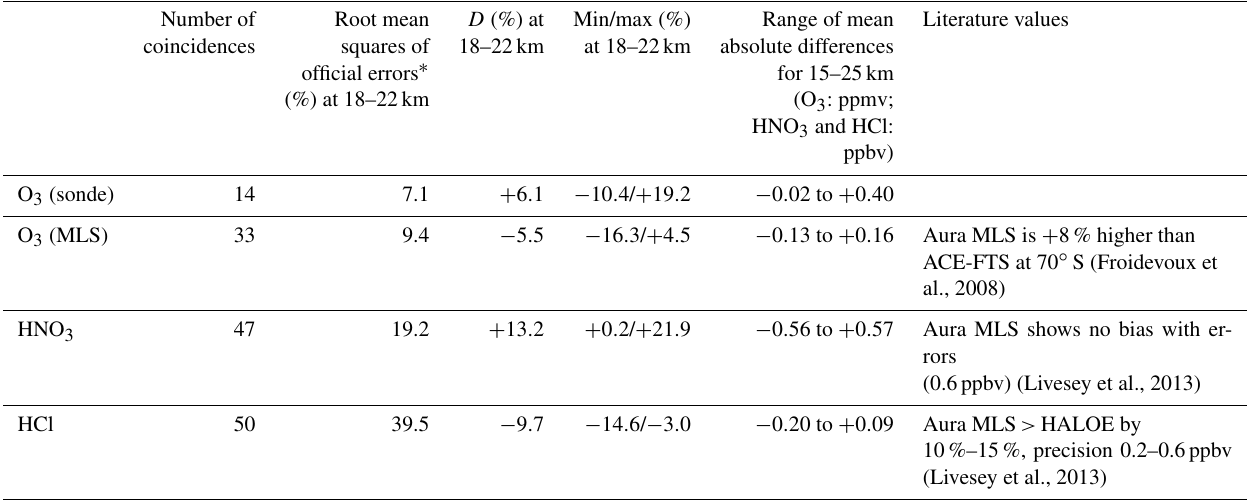
Table 2. Summary of validation results of FTIR profiles compared with ozonesonde and Aura MLS measurements, as well as possible Aura MLS biases from the literature. Number of Root mean D (%) at Min/max (%) Range of mean Literature values coincidences squares of 18–22km at 18–22km absolute differences official errors ∗ for 15–25km (%) at 18–22km (O 3 : ppmv; HNO 3 and HCl: ppbv) O 3 (sonde) 14 7.1 + 6 . 1 − 10 . 4/ + 19 . 2 − 0 . 02 to + 0 . 40 33 9.4 Aura MLS is + 8% higher than ACE-FTS at 70 ◦ S (Froidevoux et al., 2008) HNO 3 47 19.2 + 13 . 2 − 0 . 56 to + 0 . 57 Aura MLS shows no bias with er- rors (0.6ppbv) (Livesey et al., 2013) HCl 50 39.5 − 9 . 7 (Livesey et al., 2013) ∗ Root mean squares of official absolute and relative errors given by each data